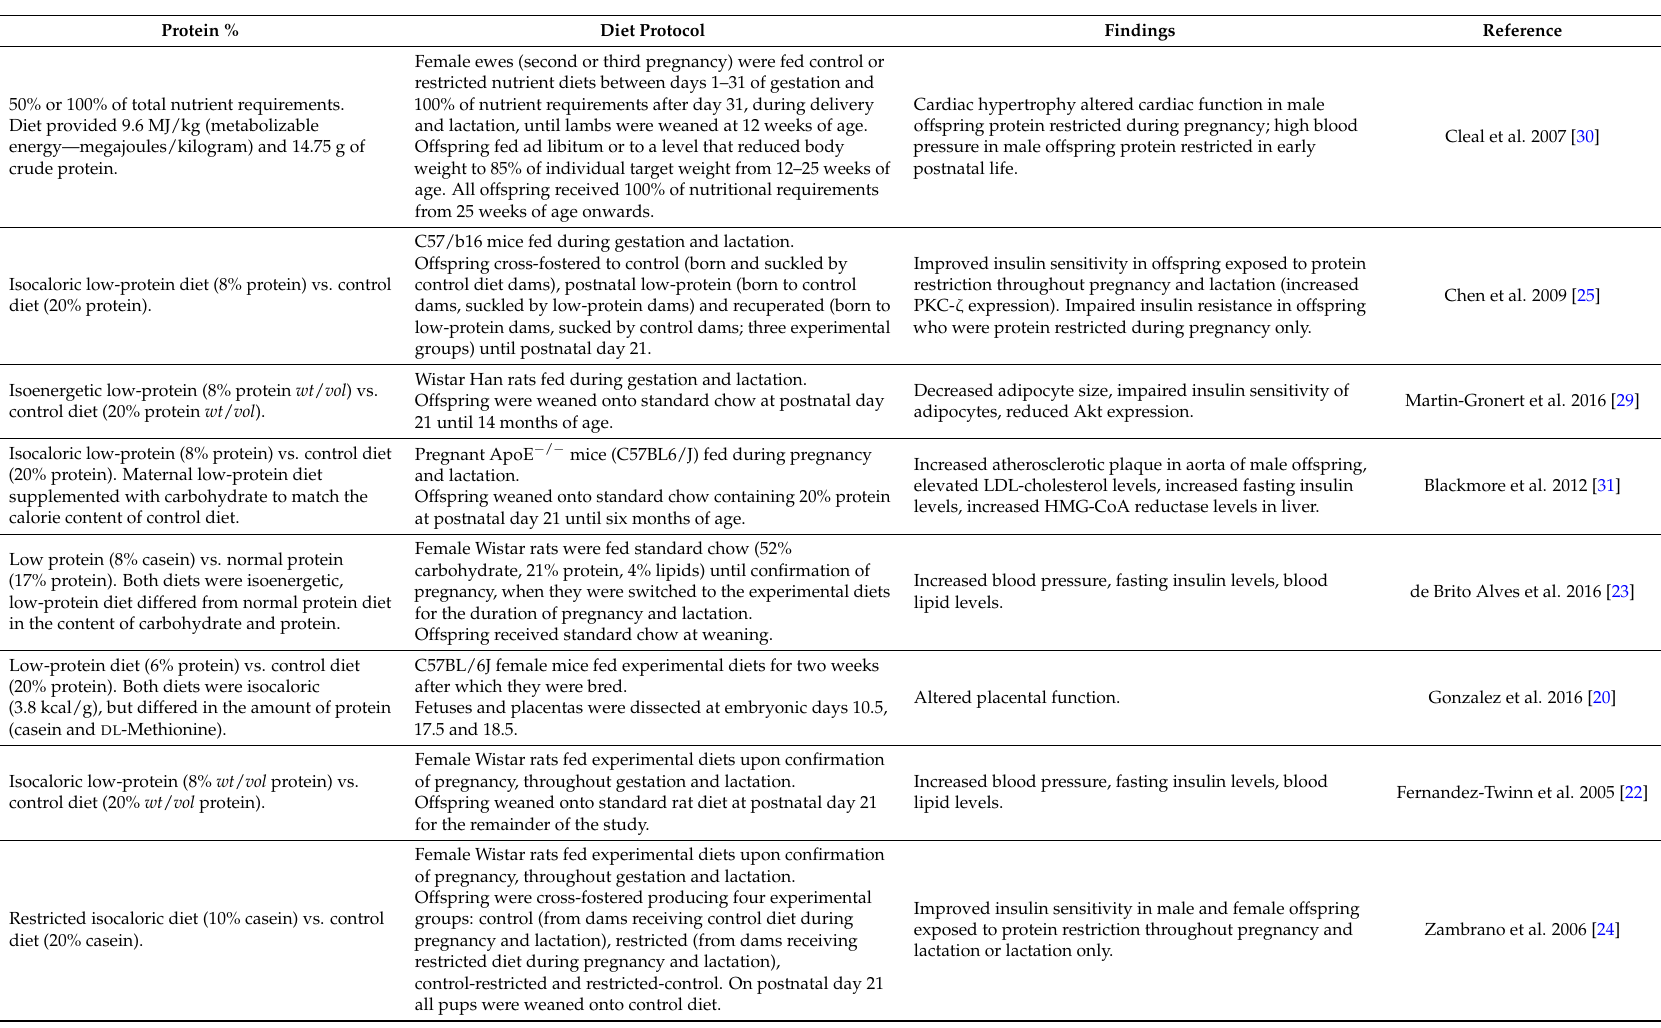
Table 1. Summary of evidence for long-term influences of maternal low-protein diets on offspring health outcomes. Protein % Diet Protocol